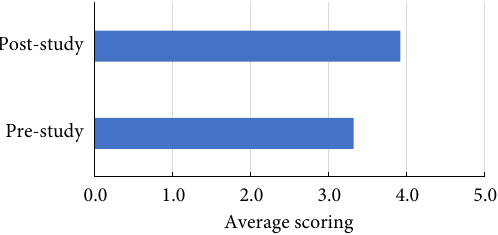
Fig. 9 Participants ’ average scoring for the pre- and post-studies for Hypothesis